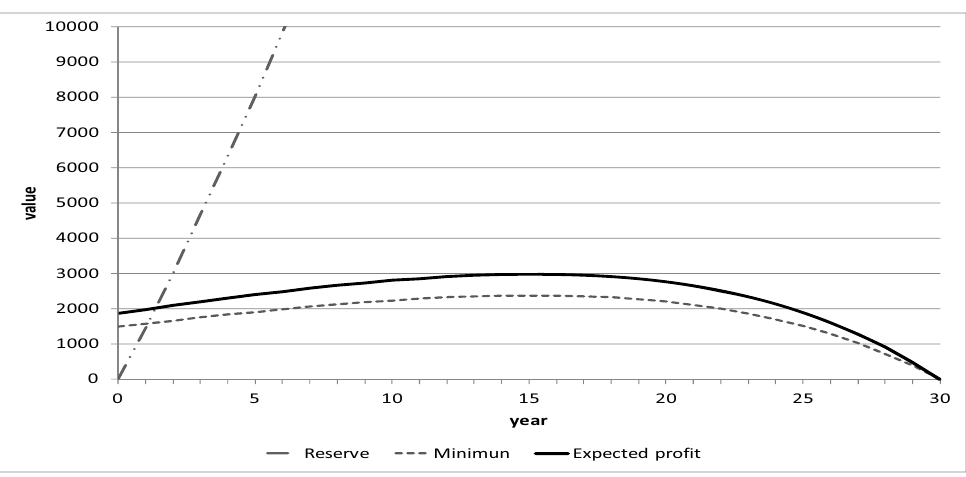
Fig. 1C. Average and percent values of the distributions of